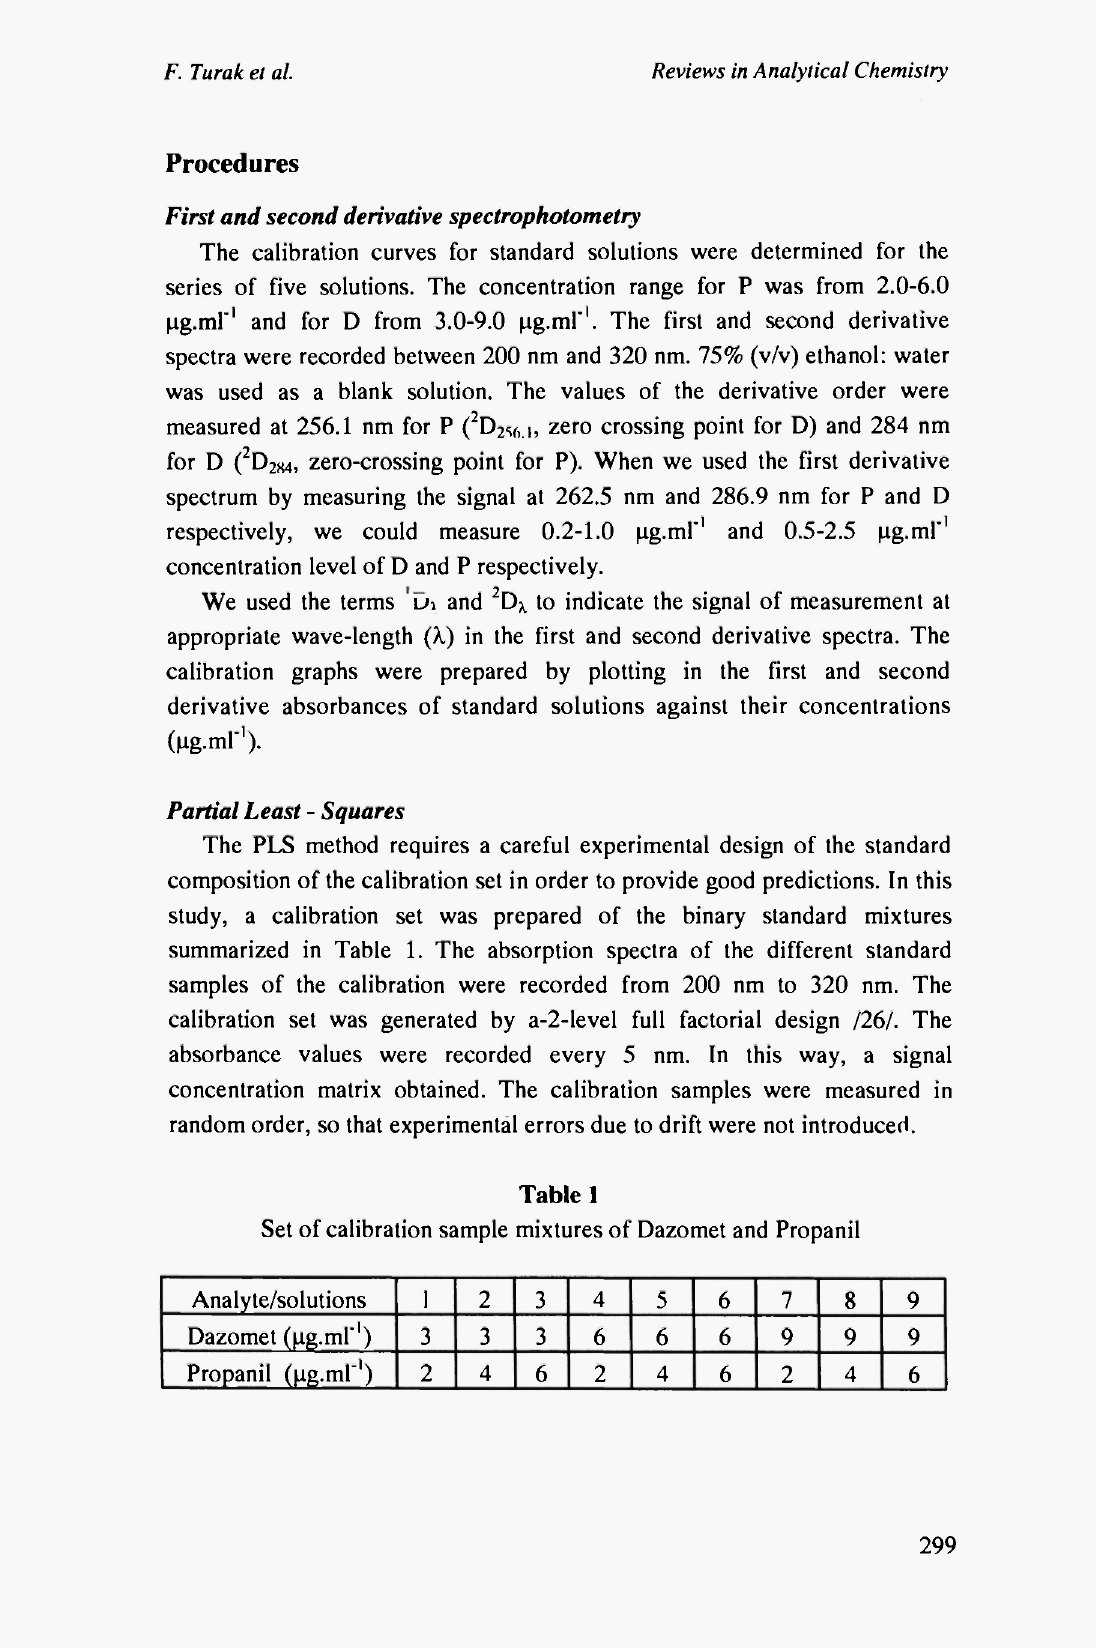
Set of calibration sample mixtures of Dazomet and Propanil